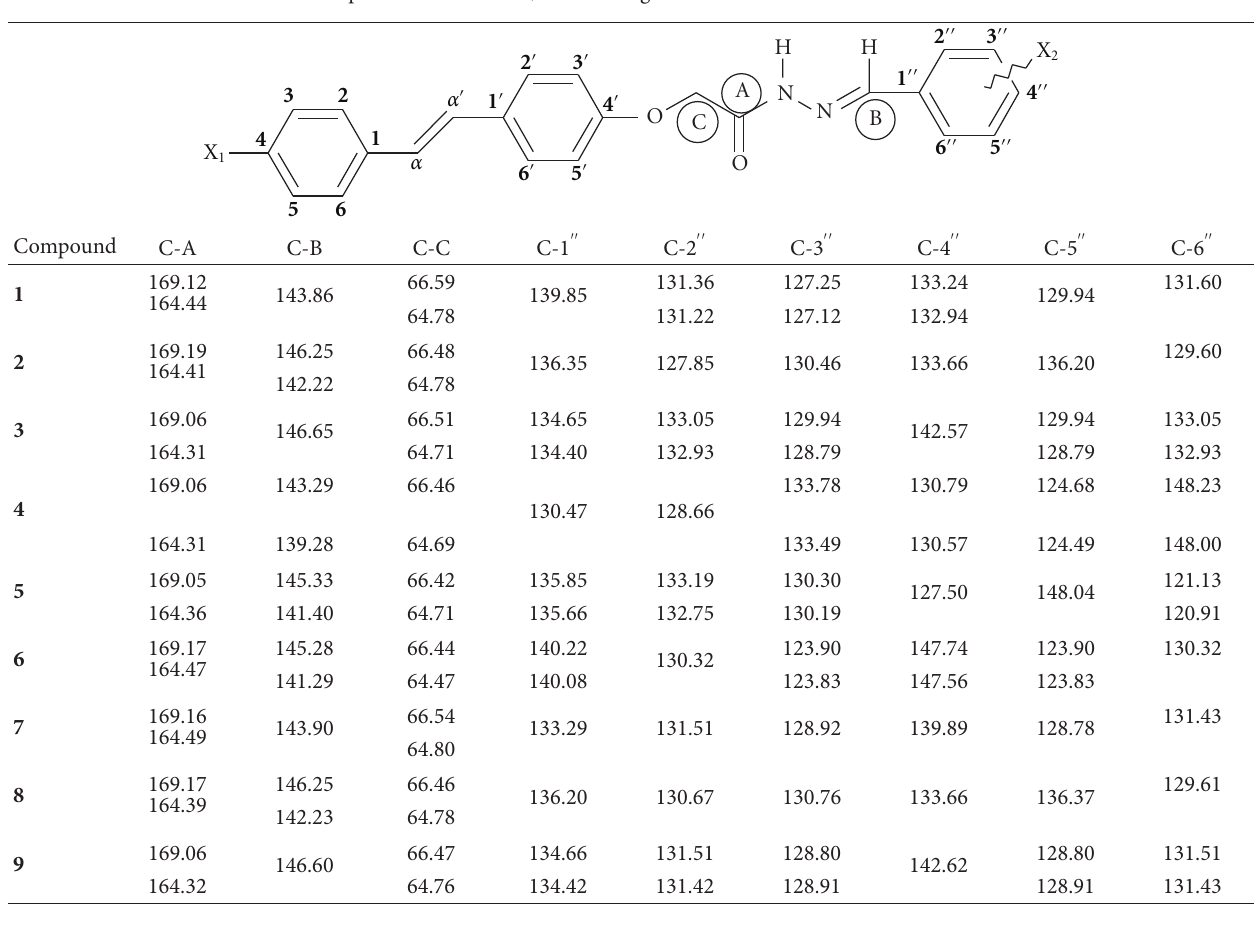
T 5: 13 C NMR data of compounds 1 – 9 —Part B; two values given for each carbon atom concern cis and trans conformers.